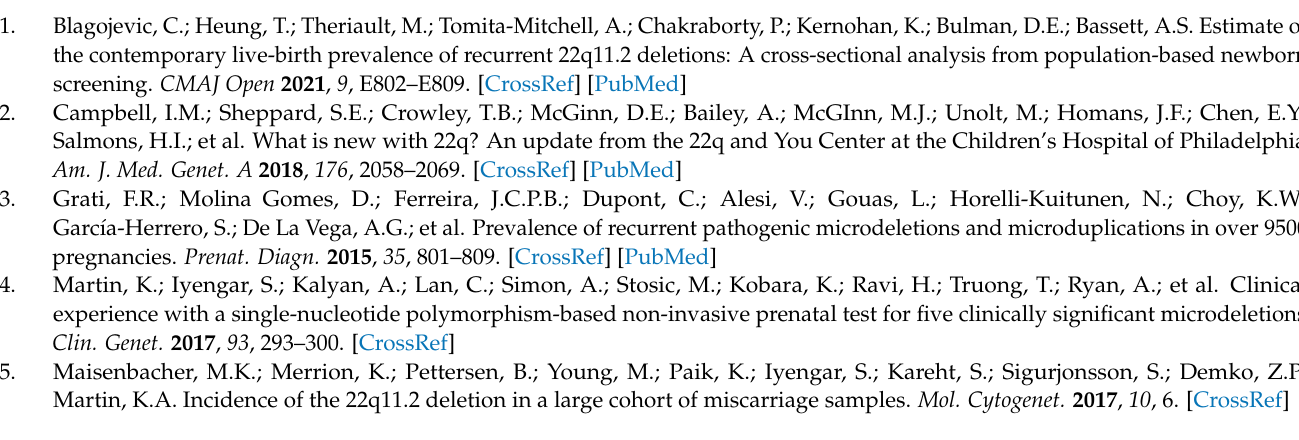
Supplementary Table S2: Summary of phenotypic characteristics of 86 patients with 22q11DS recruited for exome sequencing. Supplementary Table S3: Hemizygotic variants in the 22q11.2 deletion region. Supplementary Table S4: ClinVar pathogenic cancer predisposition. Supplementary Table S5: Variants of uncertain clinical significance. 885 variants of uncertain clinical significance were selected based on the frequency (less than 0.0001 in gnomAD database), function (exonic) and type of change (frameshift deletion, frameshift insertion, stopgain, or